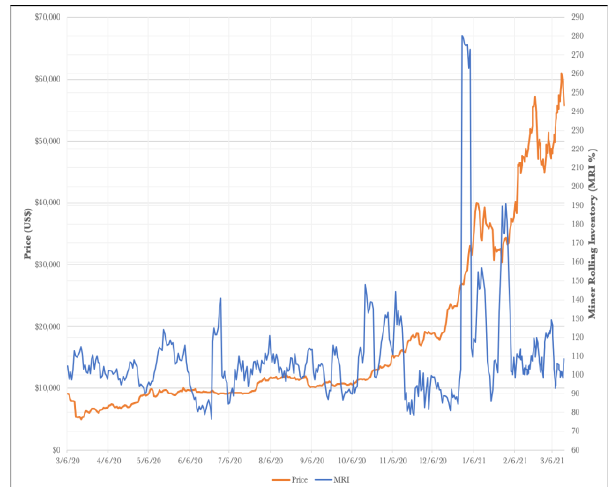
Figure 1: Miner Rolling Inventory and Price (Data Source: ByteTree